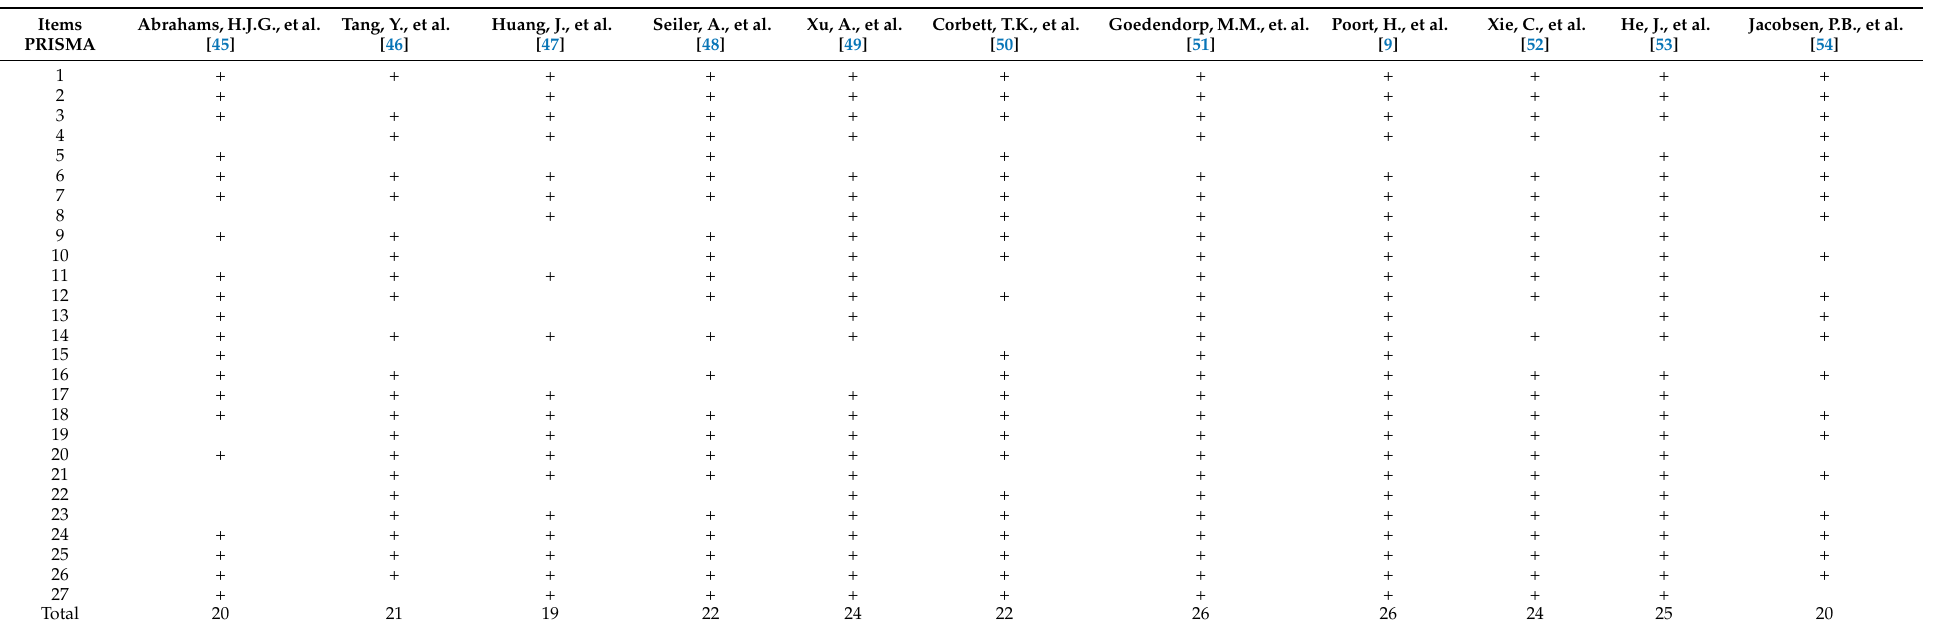
Table 2. Summary of the PRISMA methodological